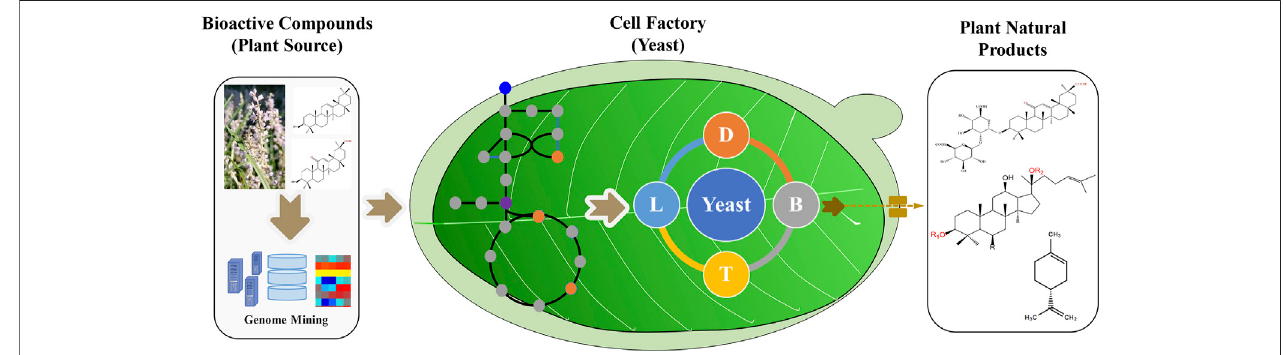
FIGURE1| Yeast-basedproductionofvaluableplantnaturalproductsbymetabolicengineeringandsyntheticbiologystrategies.Thegenescanbescreenedfrom plant omics data, and the synthetic biology tools help to engineer yeasts with the recovered enzymes and metabolism. The scale up strategies will further increase the titer, yield and rate of plant natural